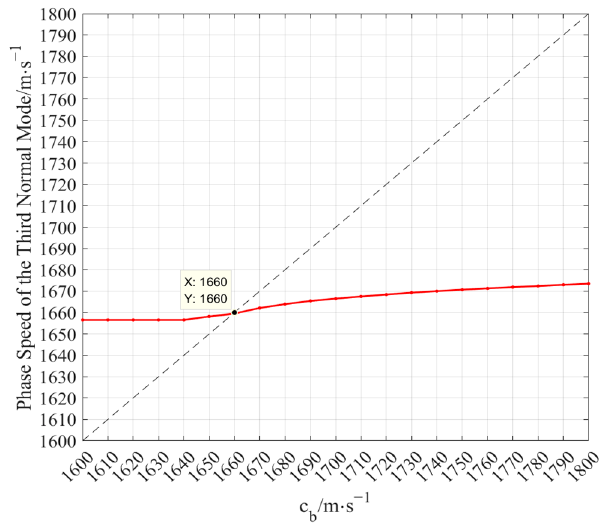
Figure 7. Variation of phase speed of third normal mode corresponding to frequency of 150 Hz with bottom sound speed (mass density and sound absorption coefficient of bottom are adopted as 1.8 g/cm 3 and 0.1 dB/ λ , respectively).